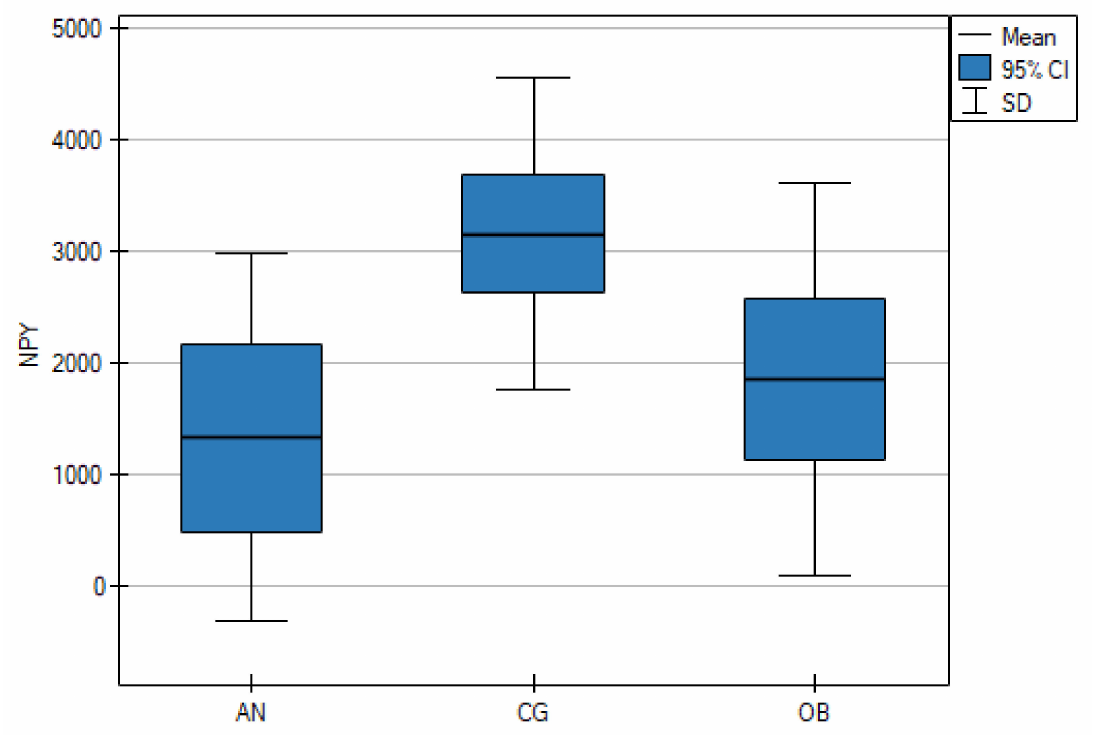
Figure 1. Fasting serum levels of neuropeptide Y (NPY) in adolescents with anorexia nervosa (AN) or obesity (OB), as well as in the healthy control group (CG).